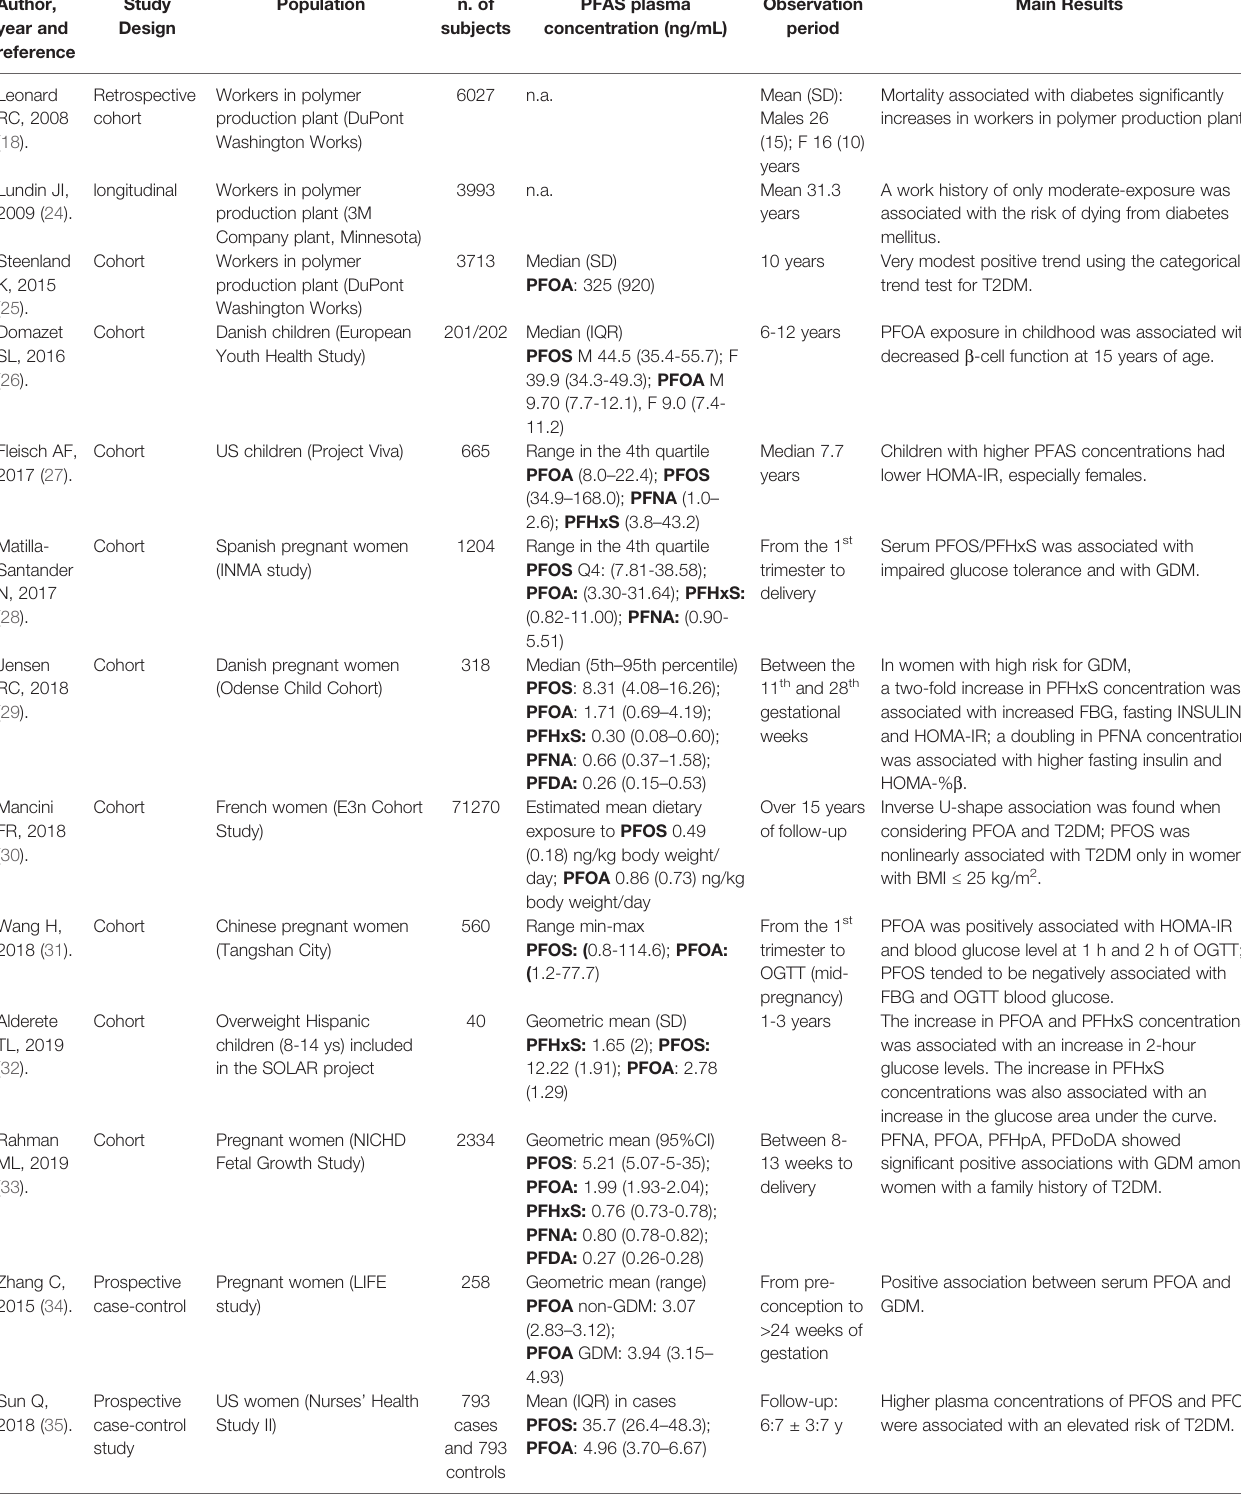
TABLE 2 | Longitudinal studies exploring the association between PFAS and glucose metabolism/diabetes